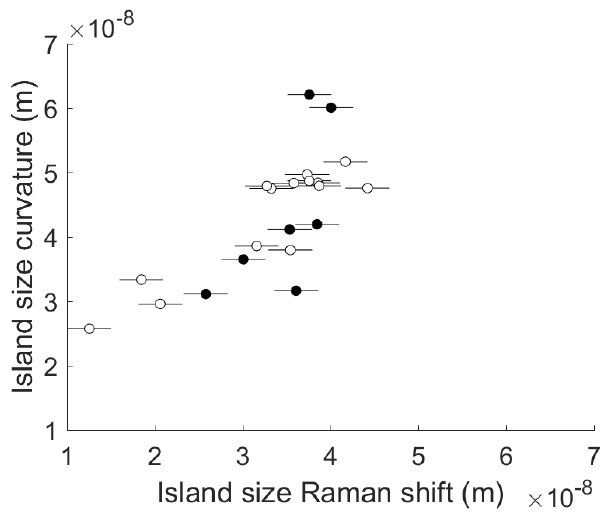
Figure 3. Island size deduced from Raman shift versus island size deduced from curvature. Full dots indicate samples with cracks. Standard deviation is indicated in both directions.